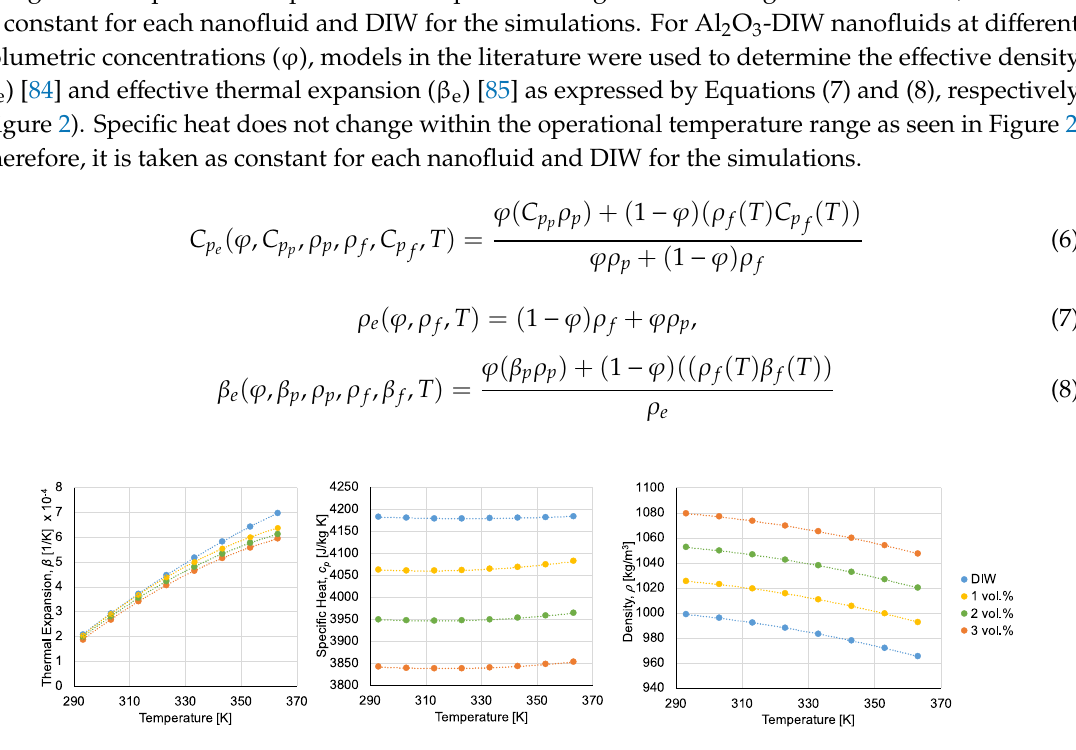
Figure 2. Temperature-dependent thermal expansion, specific heat and density values for working fluids. Both data points and polynomial fits are given in the figure.